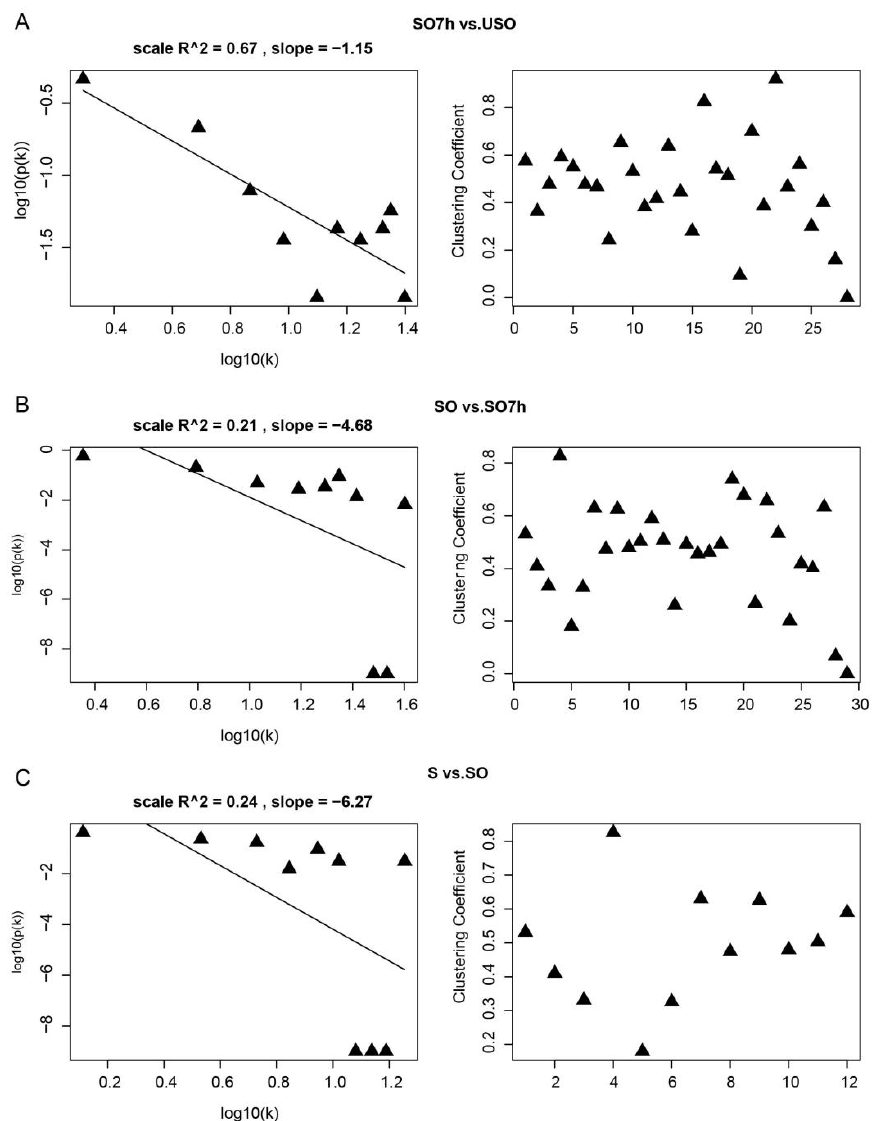
Figure 4. Network topology analysis results for PPI networks based on each comparison. ( A ) SO7h vs. USO. ( B ) SO vs. SO7h. ( C ) S vs. SO.